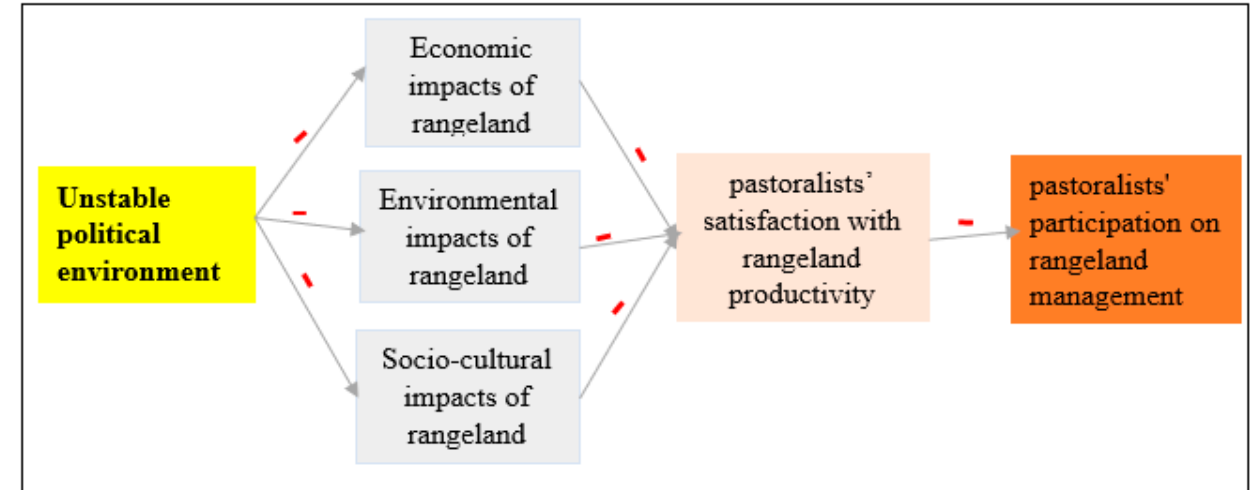
Figure 2. Theoretical model of impacts and perceptions of political instability.